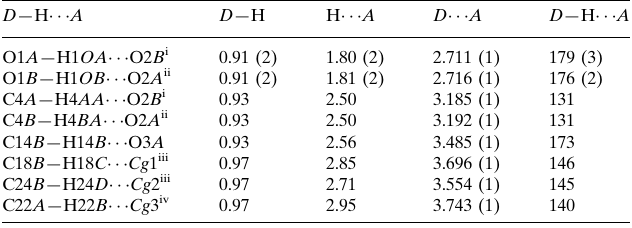
Hydrogen-bond geometry (A˚ , (cid:2)